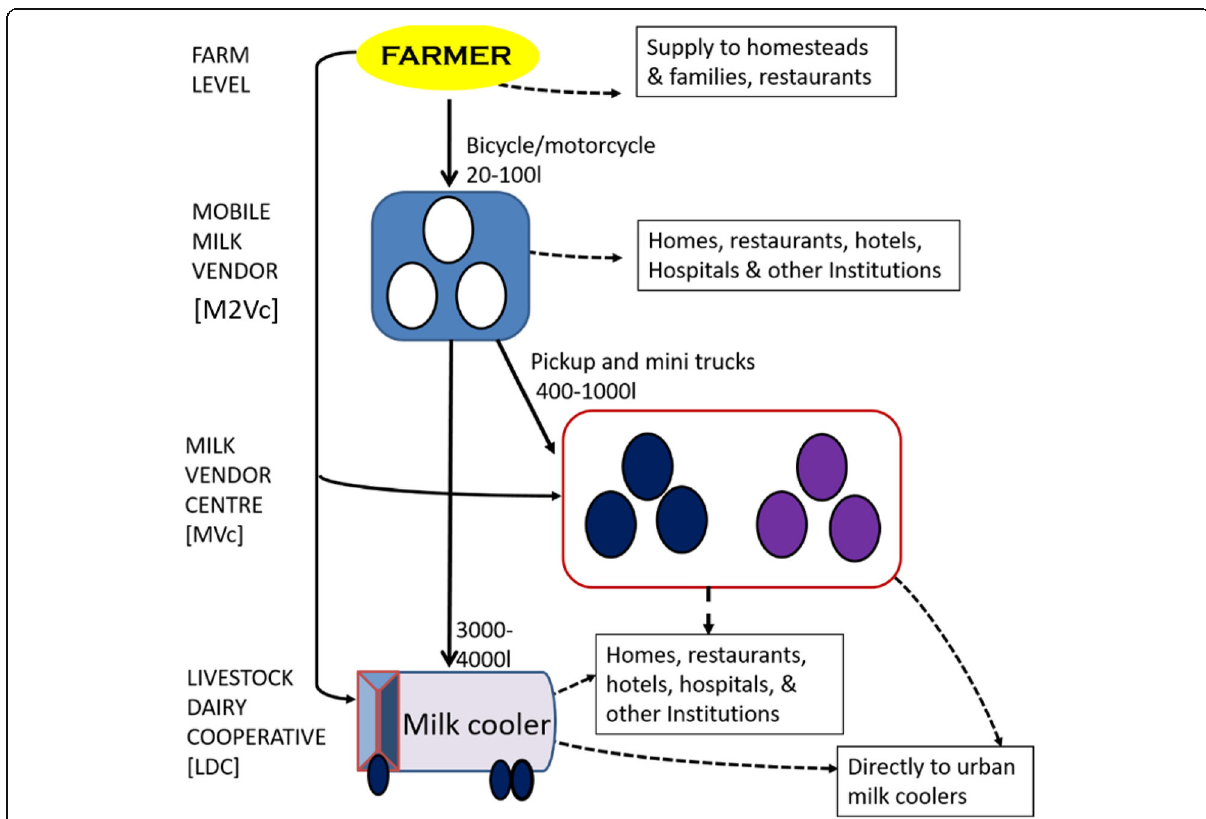
Fig. 2 Key players in the milk value chain in Nakasongola district. Practices affecting the quality of milk in the milk value chain in